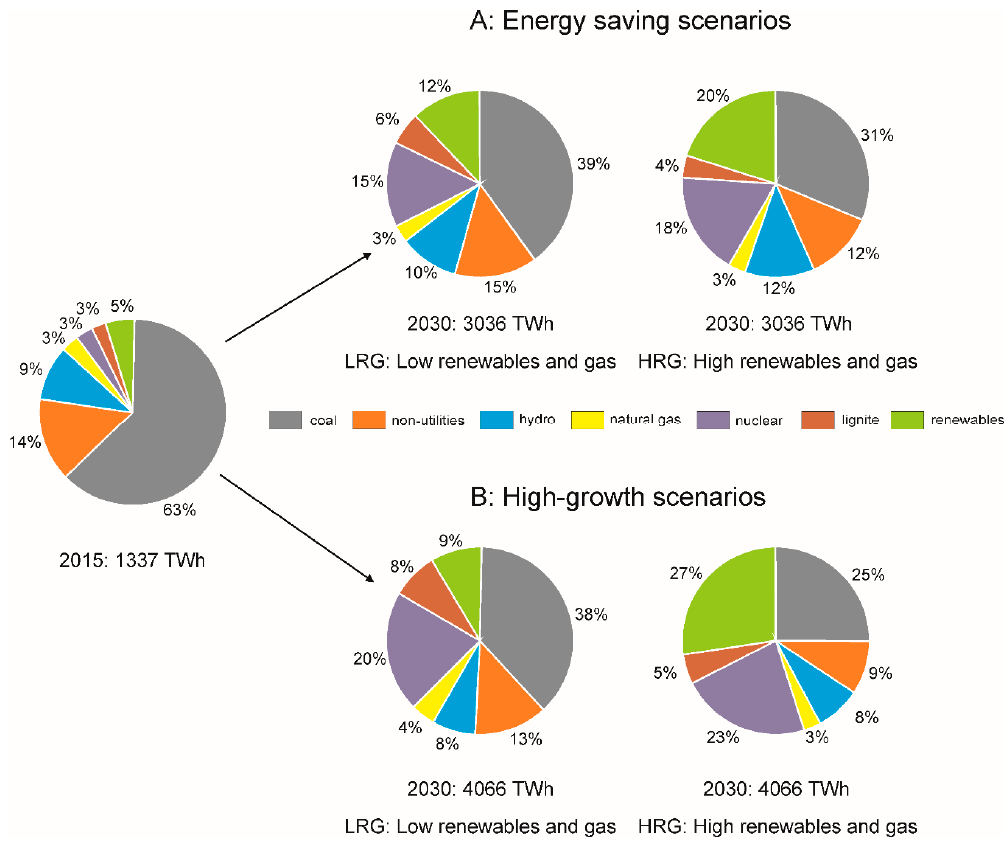
Figure 6. Electricity generation for the energy-saving and high-growth scenarios.